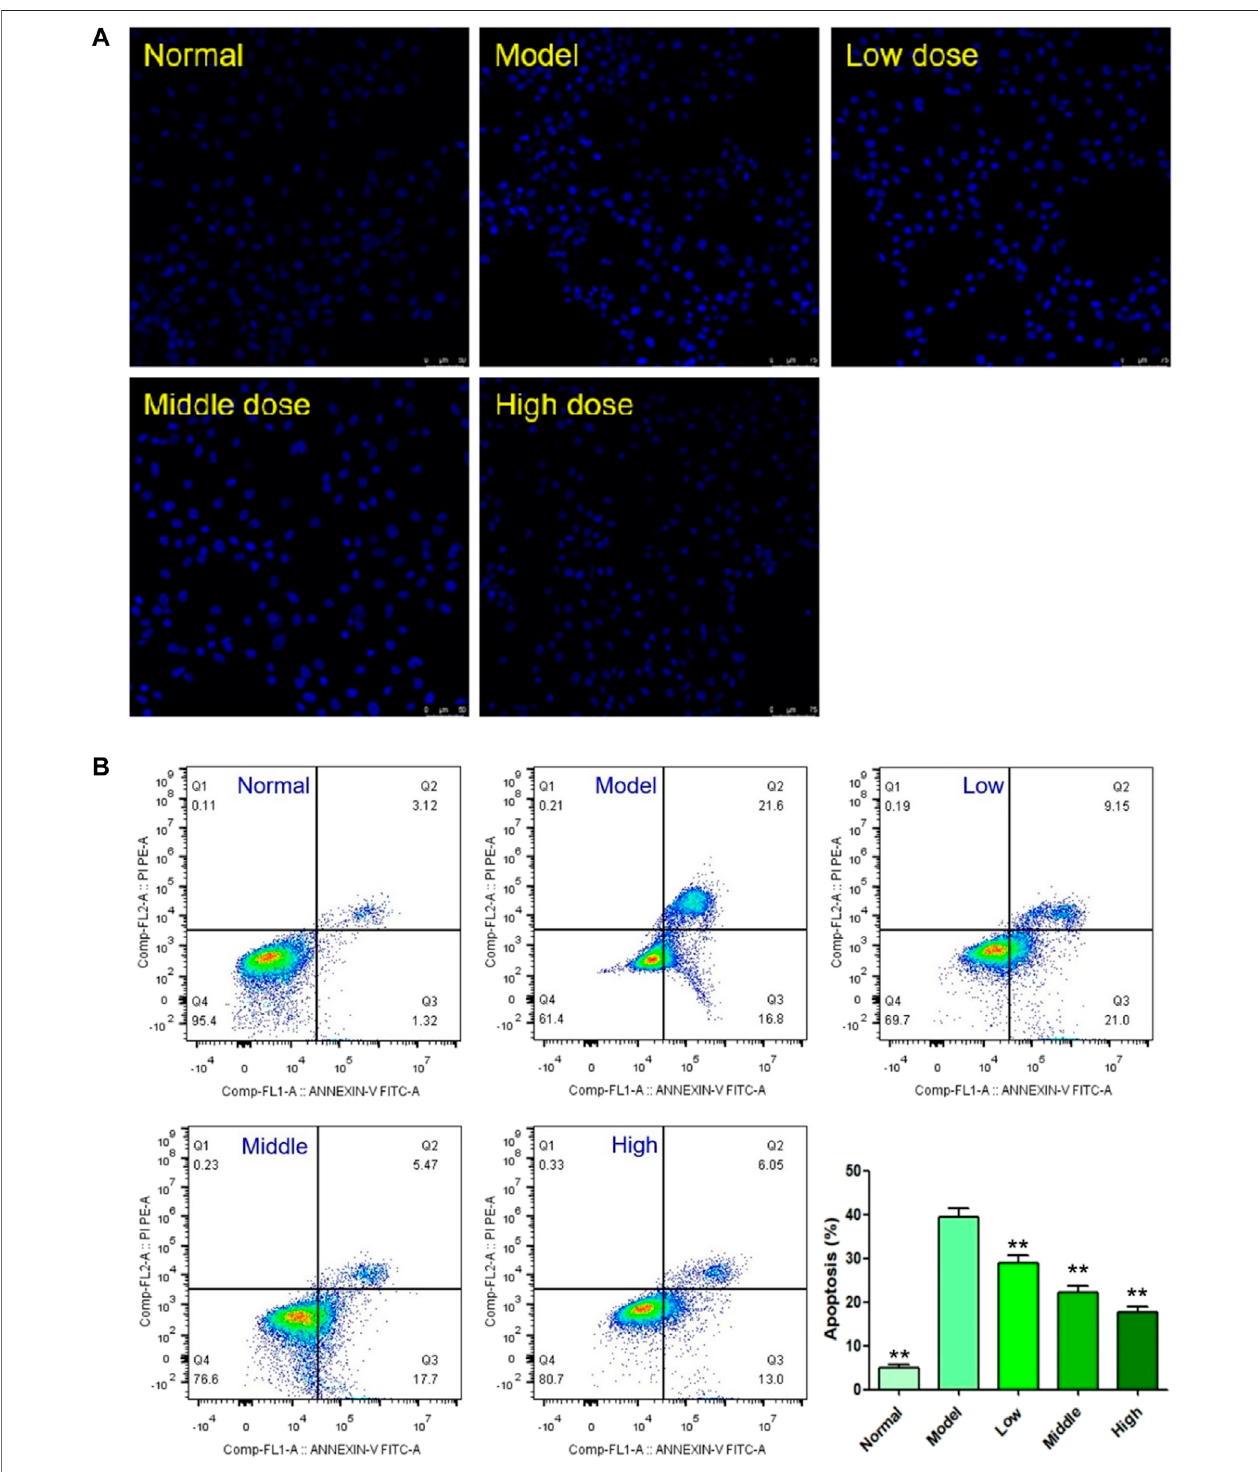
FIGURE 6 | Effects of YTC on apoptosis in H 2 O 2 -stimulated H9c2 cells. (A) Apoptotic assay by DAPI staining. (B) Apoptotic assay by fl ow cytometry. The values were represented as the mean ± SD ( n = 3). pp p < 0.01 vs the model group.